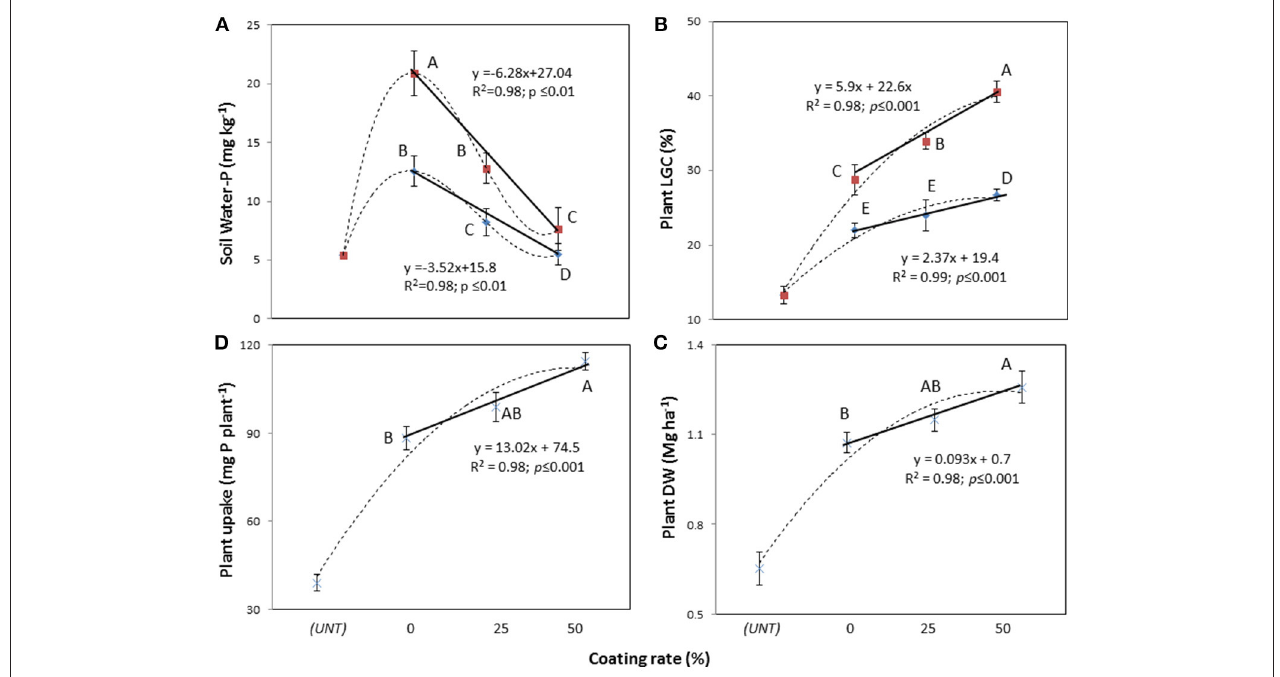
FIGURE 2 | Linear response of soil water-P concentrations (A) , plant’s living ground cover (LGC) index (B) , dry weight (DW) (C) , and P uptake (D) on polymer-coated mono-ammonium phosphate at two rates of coating (25 and 50%) and untreated (UNT). Treatments were: 0.7g P plant − 1 , line with blue rhombus; 1.4g P plant − 1 , line with red squares; continuous line, relationship considering coating rate; dotted line, relationship considering coated and untreated soils. Means with the same letter are not significantly different at the 0.05 probability level. Bars indicate standard deviation.